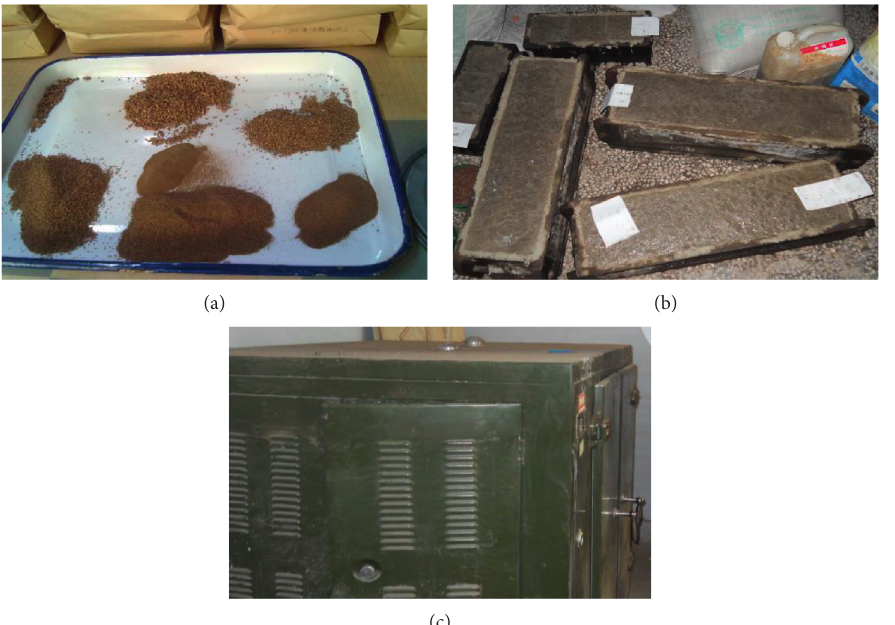
Figure 1: Process of making geopolymer concrete. (a) Raw materials for experiment. (b) Coal gangue-based geopolymer concrete. (c)